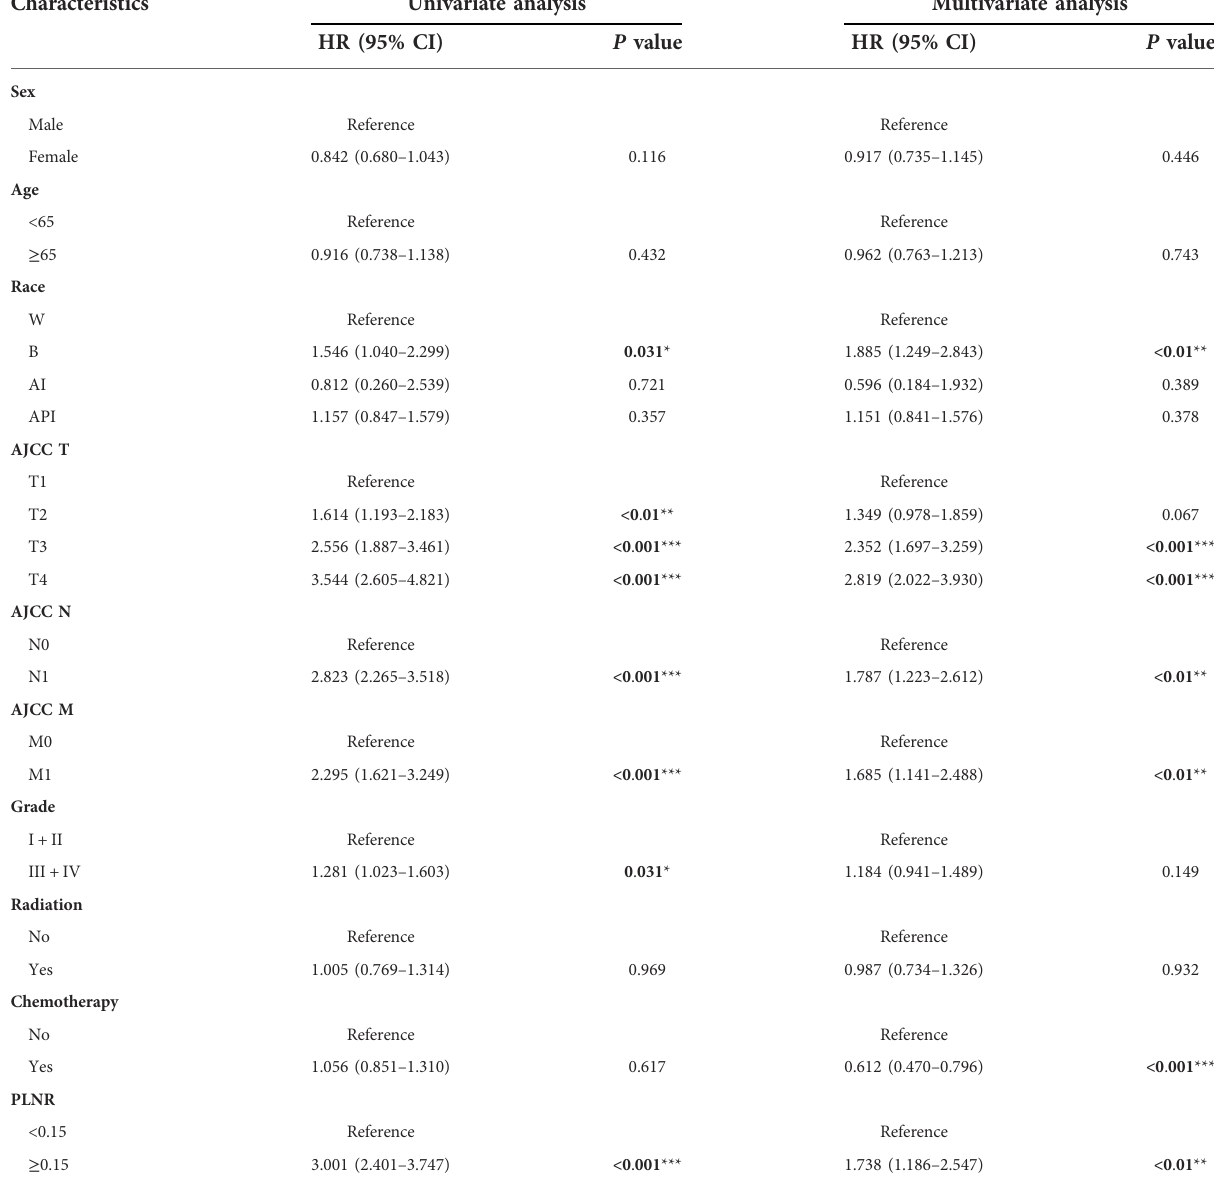
TABLE 2 Univariate and multivariate cox regression analysis based on all variables for ICC patient cancer-speci fi c survival (training